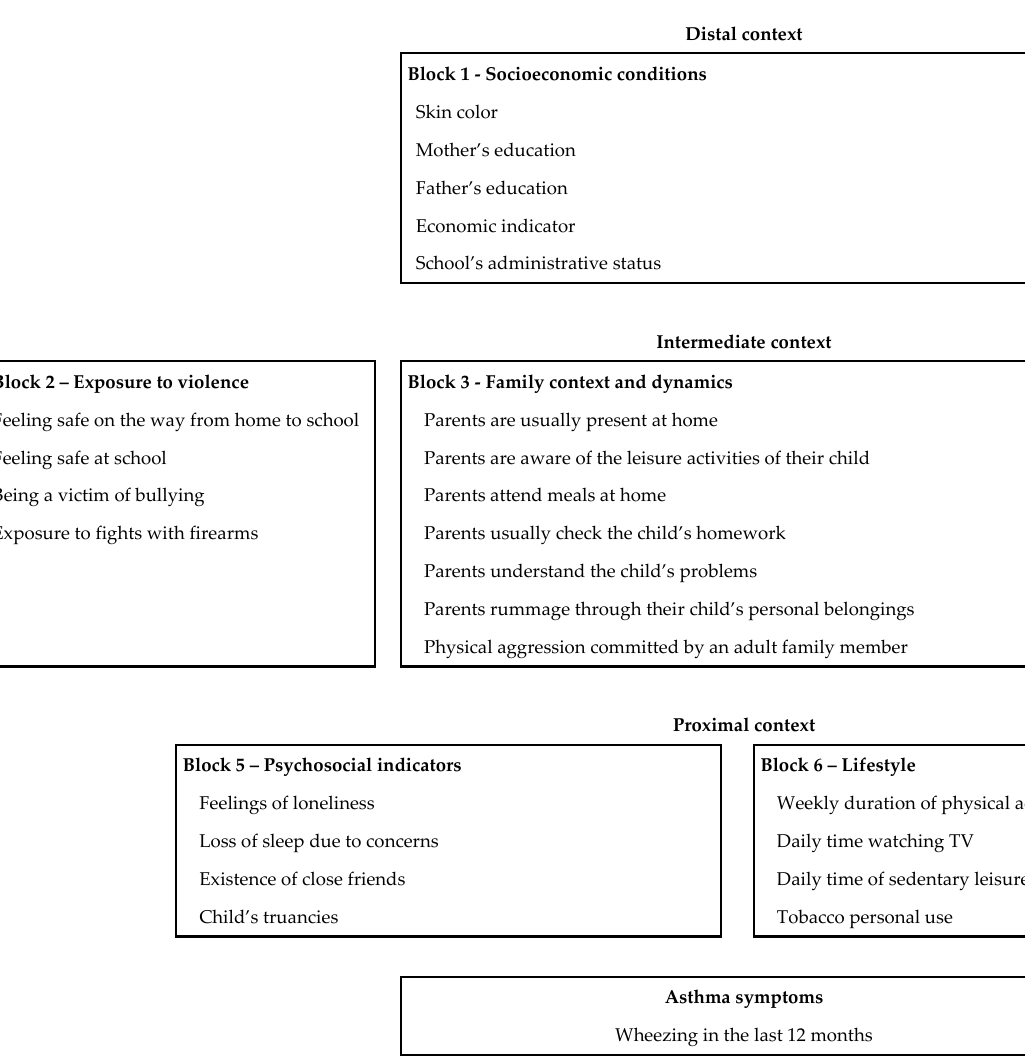
Figure 1. Hierarchical Conceptual Model of Risks Associated with Asthma Symptoms in Brazilian Middle School Students (PeNSE Survey, 2012).